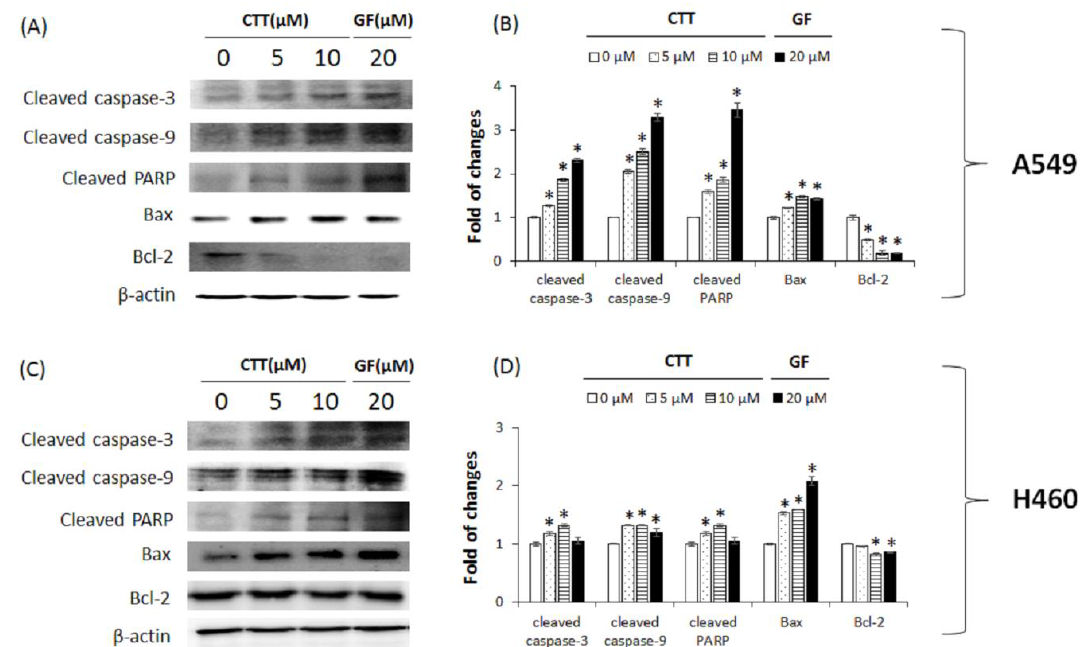
Figure 3. Effects of CTT treatment on the expression of apoptosis-related pathway proteins in A549 and H460 cells. ( A , C ) After treatment with 0, 5, or 10 μM of CTT or 20 μM GF (clinical anticancer drug) for 20h, the protein levels of cleaved caspase-3, cleaved caspase-9, cleaved PARP, Bax, and Bcl-2 were determined through western blotting. ( B , D ) The calculations of the results were normalized against β-actin. * p < 0.05 compared to the 0 μM of CTT group. The data and images represent each of the three independent experiments. Significant differences for the treated groups were determined by Duncan’s test for multiple comparisons. Values are represented as the mean ± SD from each